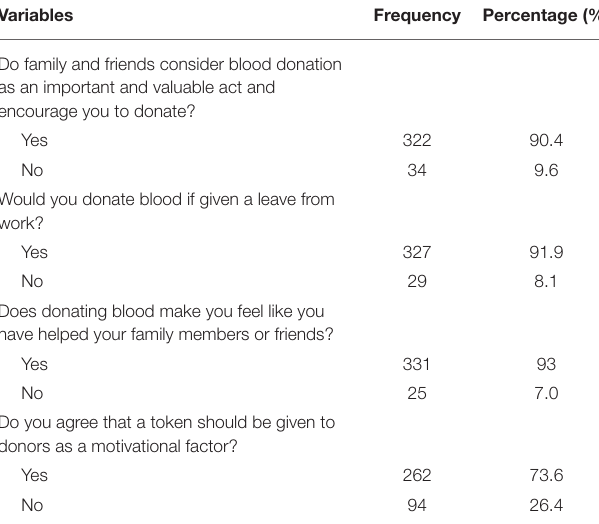
TABLE 4 | Factors motivating blood